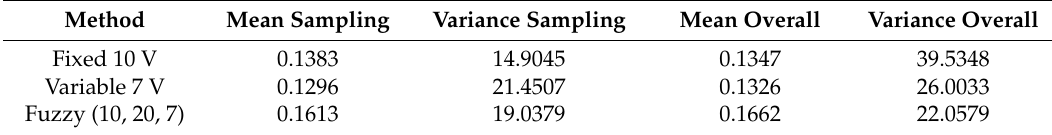
Figure 12. Evaluations of experimental results for selected test: ( a ) evaluation of p BUS ; ( b ) evaluation of of u BUS ; ( c ) evaluation of ∆ u ; ( d ) evaluation of p DIFF . Table 5. Means and variances for all power control methods.